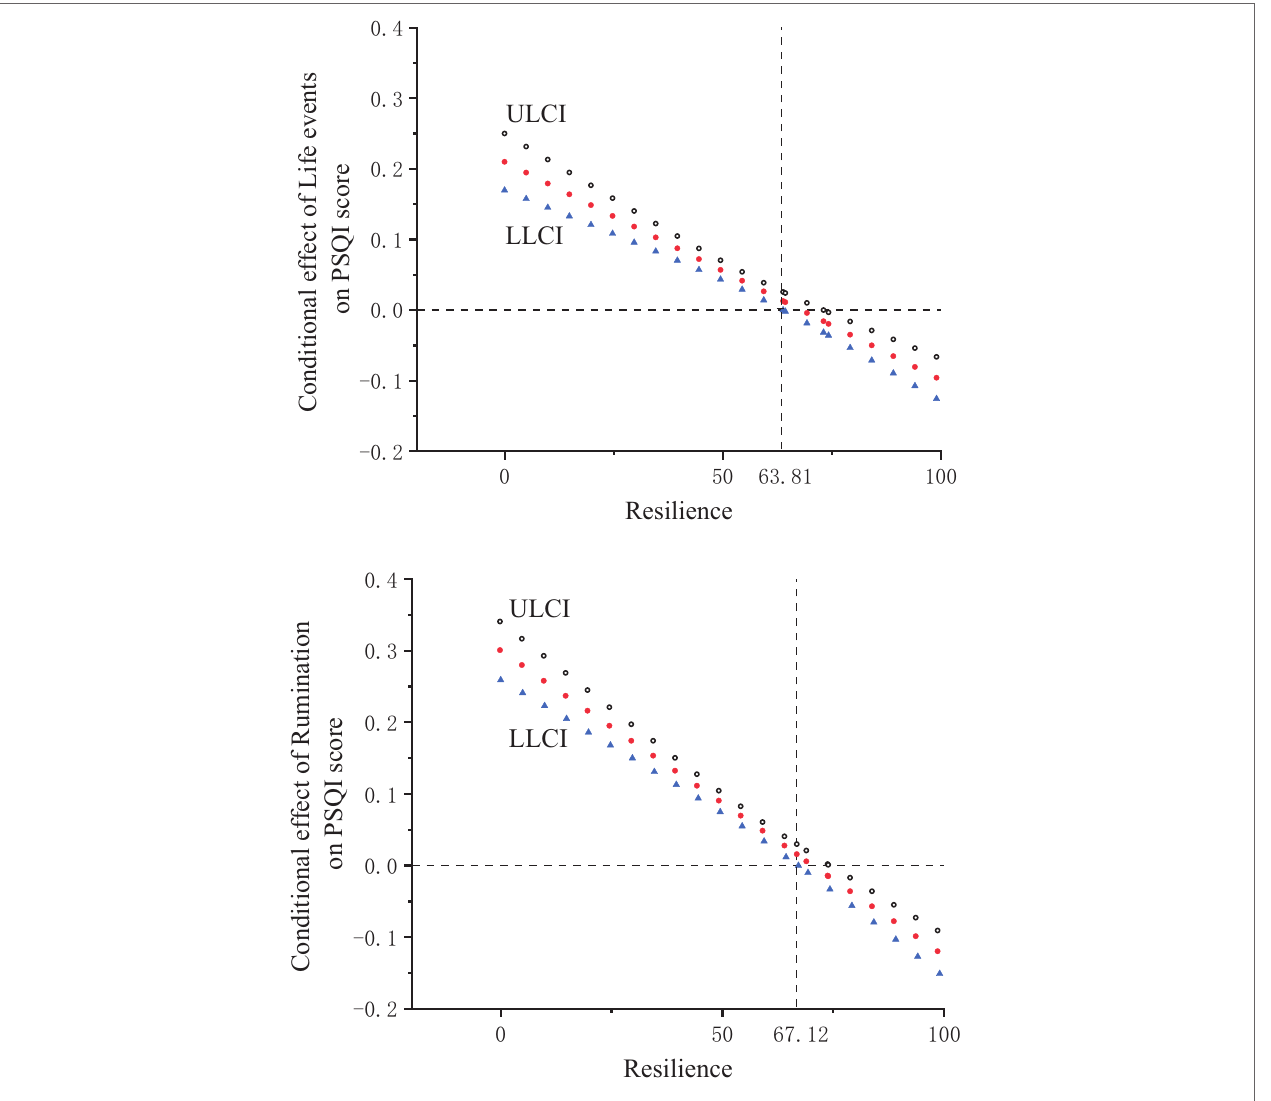
FIGURE 3 | Visual representation of the conditional effect of stressful life events/rumination on sleep quality as moderated by resilience (LLCI, lower level for confidence interval; ULCI, upper level for confidence